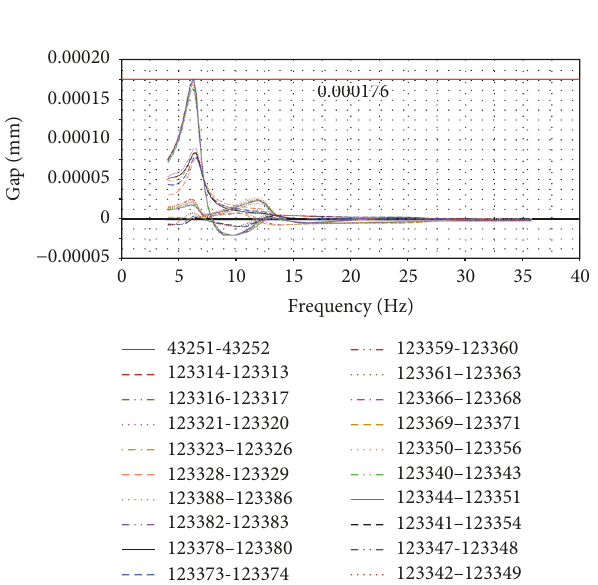
Figure 14: The relative displacement-frequency curve of the two ends of the spring.